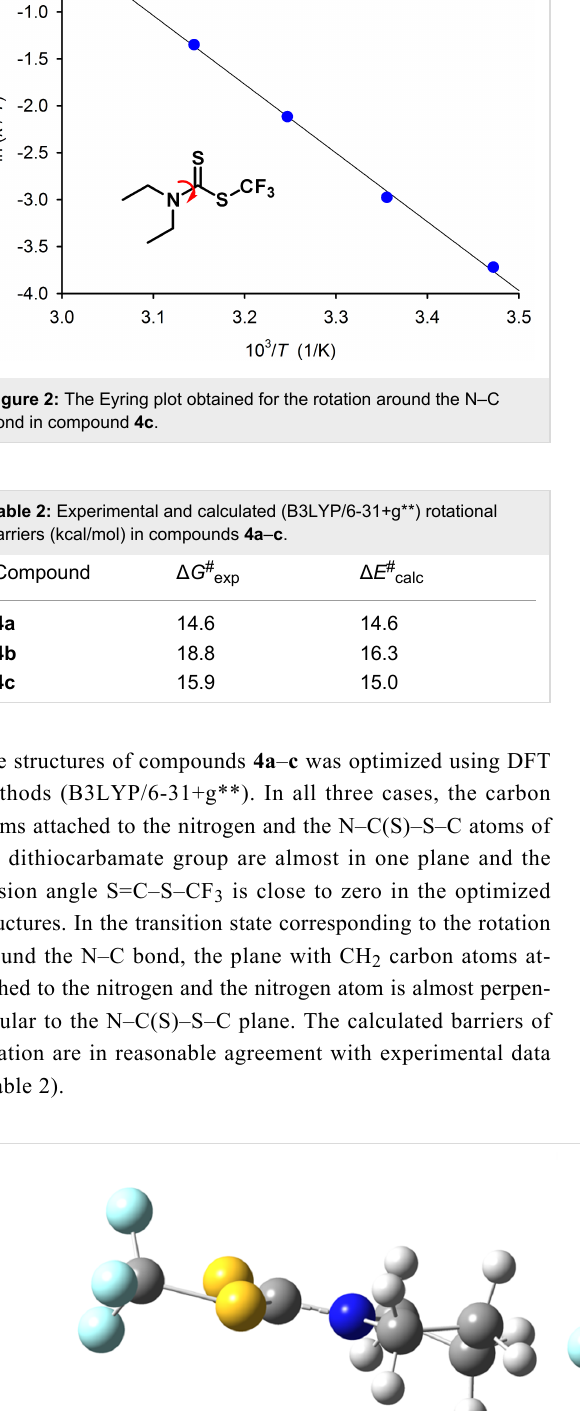
The rotational barriers obtained for compounds 4a – c are sum- marized in Table 2.